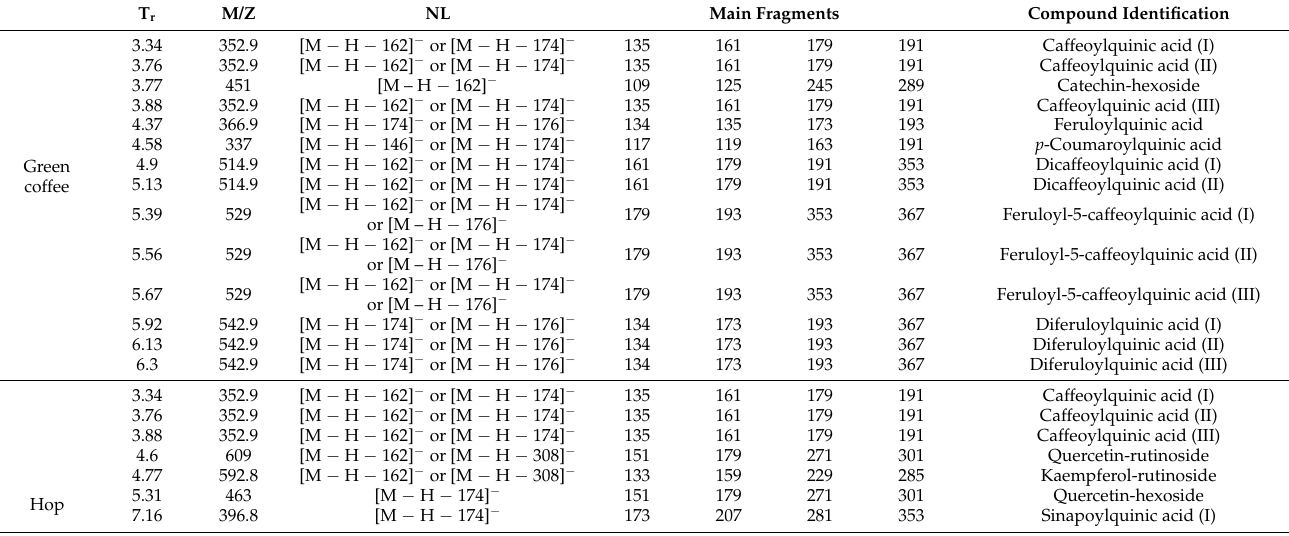
Table 2. Green coffee, hop and saffron samples analyzed using the proposed NL-IDA-EPI acquisition method. Different isomeric forms were tagged with (I), (II), (III) for caffeoylquinic acid, feruloyl-5- caffeoylquinic acid and diferuloylquinic